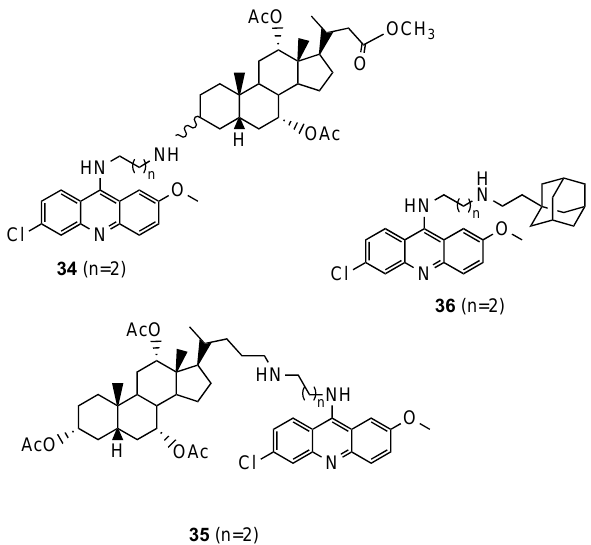
Figure 23. Steroidal ( 34 and 35 ) and adamantane ( 36 ) aminoacridine derivatives synthesized by Tot and co-workers